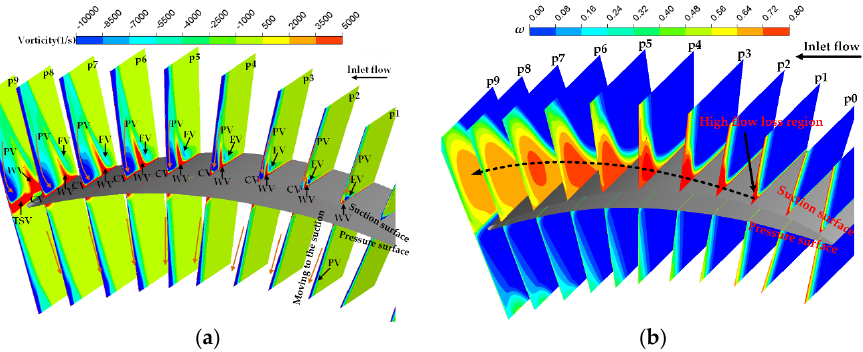
Figure 7. Flow structures within the high-speed compressor cascade corner separation and the development of the corresponding flow loss at an incidence angle of 8°. ( a ) Flow structures. ( b ) The development of flow loss.